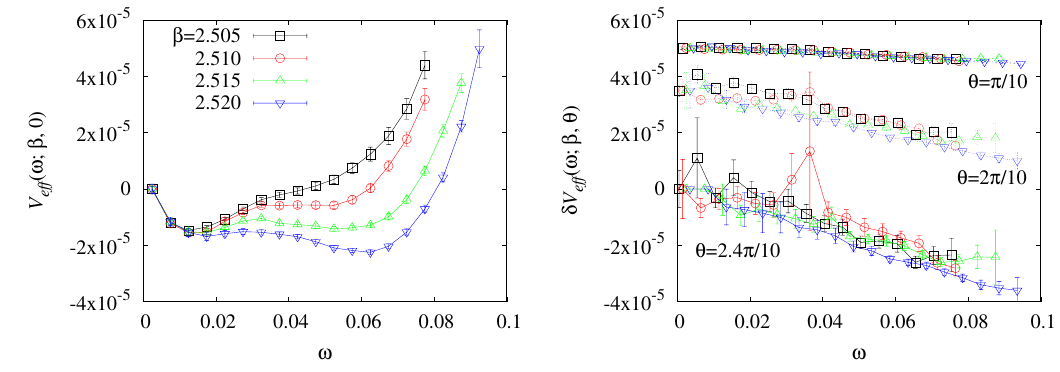
Figure 4 . V eff ( ω ; β, 0) (left) obtained at four β values and δV eff ( ω ; β, θ ) (right) for four β and three different θ . In both plots, the same symbols are used and the data are shifted in the vertical direction for visibility.